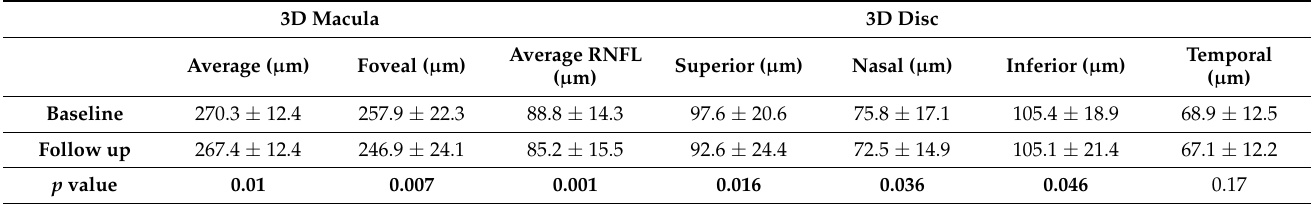
(Figure 3b) and fovea (Figure 3c). Disability progression, documented in 19/20 patients, is shown in Figure 3d (mean SARA at baseline 18.9 ± 6.5, at follow-up 21.9 ± 6.5, p < 0 .05). Table 4. Analysis of macular and RNFL thickness over time. Table 4. Analysis of macular and RNFL thickness over time.